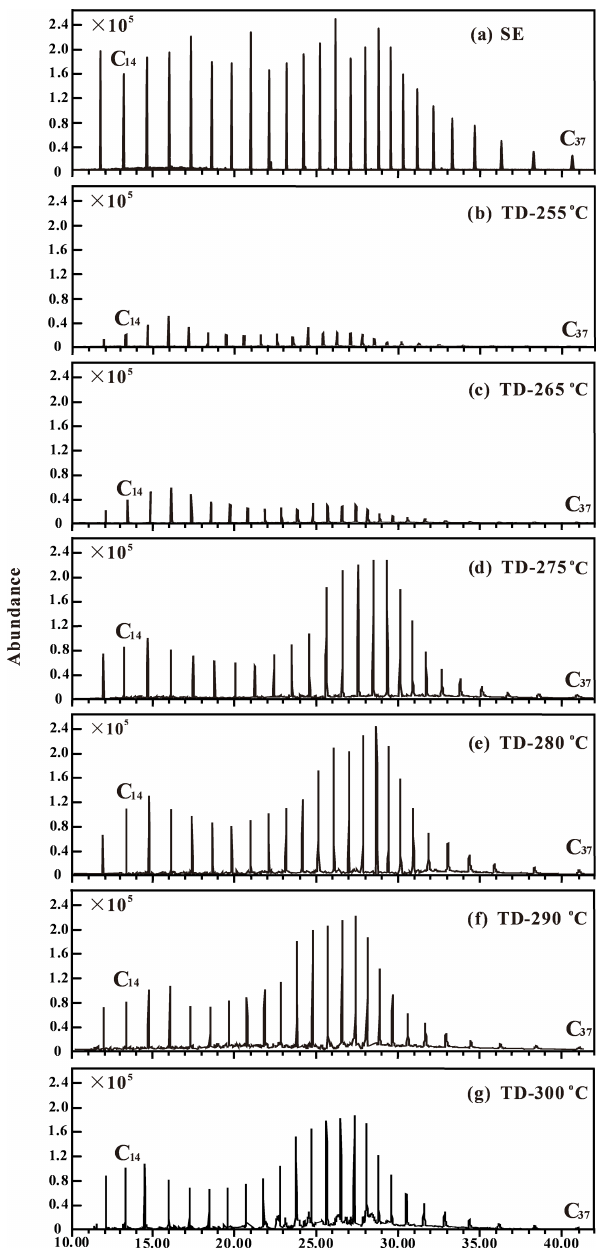
Figure 1. Comparison of GC-MS chromatograms from solvent ex- traction (SE, a ) and thermal desorption (TD) at different injector port temperatures of 255 ◦ C (b) , 265 ◦ C (c) , 275 ◦ C (d) , 280 ◦ C (e) , 290 ◦ C (f) and 300 ◦ C (g)